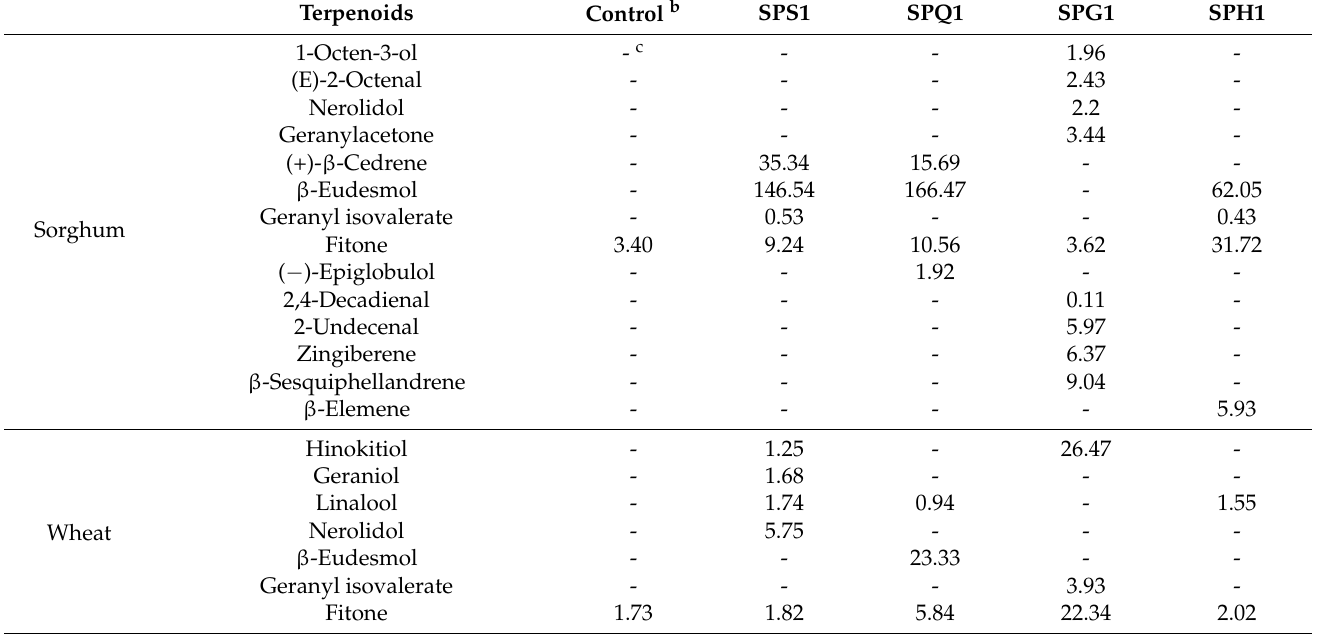
Table 1. The content ( µ g/kg) of terpenoids produced by liquid fermentation a .